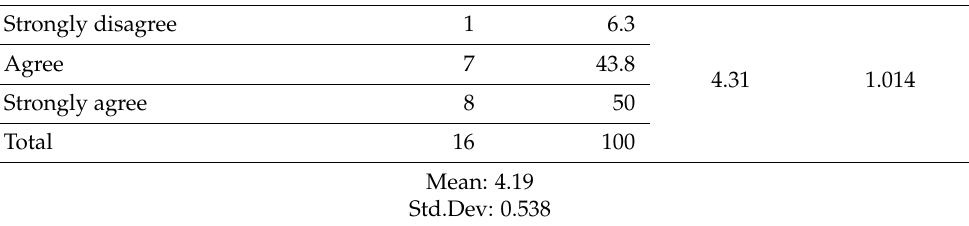
Table 5. Cont. Product value recovery through recycling and repackaging Strongly disagree